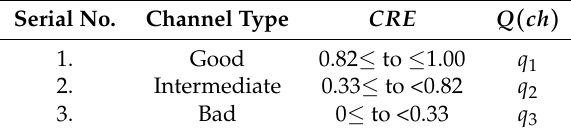
Table 4. β - tracker based channel quality level Q ( ch ) assignment with q 1 = 0.3, q 2 = 0.2, q 3 = 0.1. Serial No.